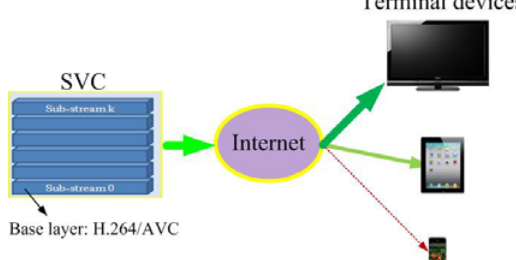
Fig.1. H.264/SVC scalable video distribution